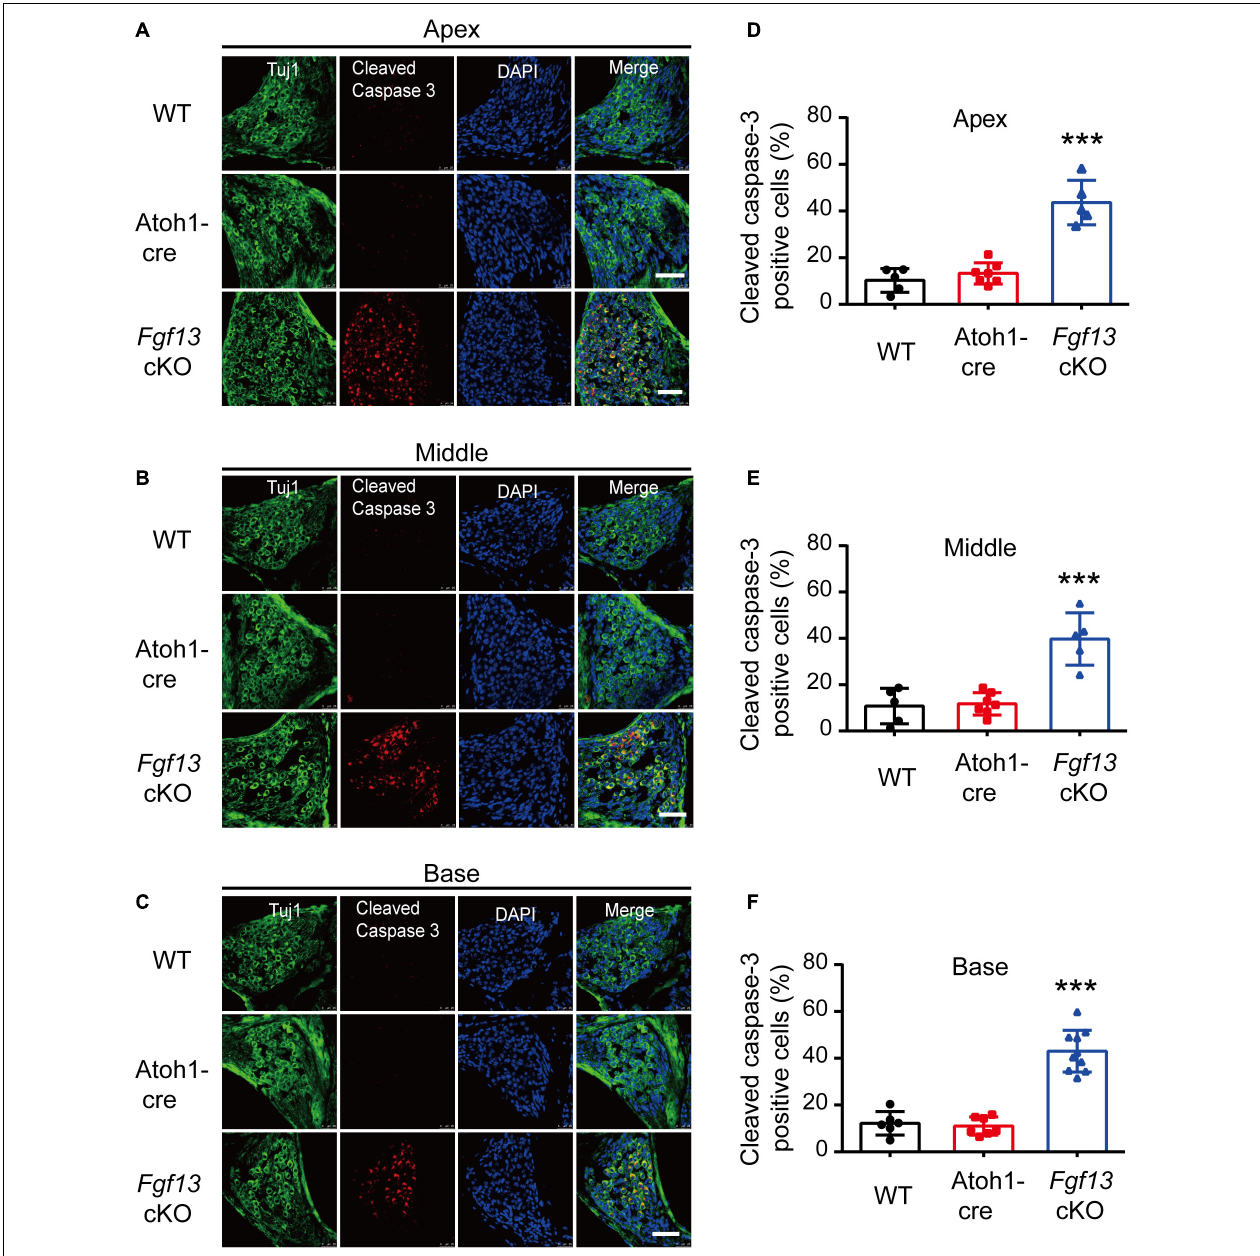
FIGURE 8 | Fgf13 cKO induces activation of cleaved-caspase-3 in SGNs. (A–C) The expression of cleaved-caspase-3 in cochlea SGNs from the apex to the base in WT, Atoh1-cre and Fgf13 cKO mice. Scale bar = 50 µ m. (D–F) Quantitative analysis of cleaved-caspase-3 positive cells in apex (D) , middle (E) , and base (F) for WT, Atoh1-cre and Fgf13 cKO mice. Apex and Middle: n = 5/WT (4 M and 1 F); n = 7/Atoh1-cre (4 M, 3 F); n = 5/ Fgf13 cKO (3 M, 2 F). Base: n = 6 (5 M and 1 F) for WT, n = 7/Atoh1-cre (4 M, 3 F); n = 10/ Fgf13 cKO (7 M, 3 F). F, female, M, male. *** P < 0.001 compared with controls as detected by One-Way ANOVA